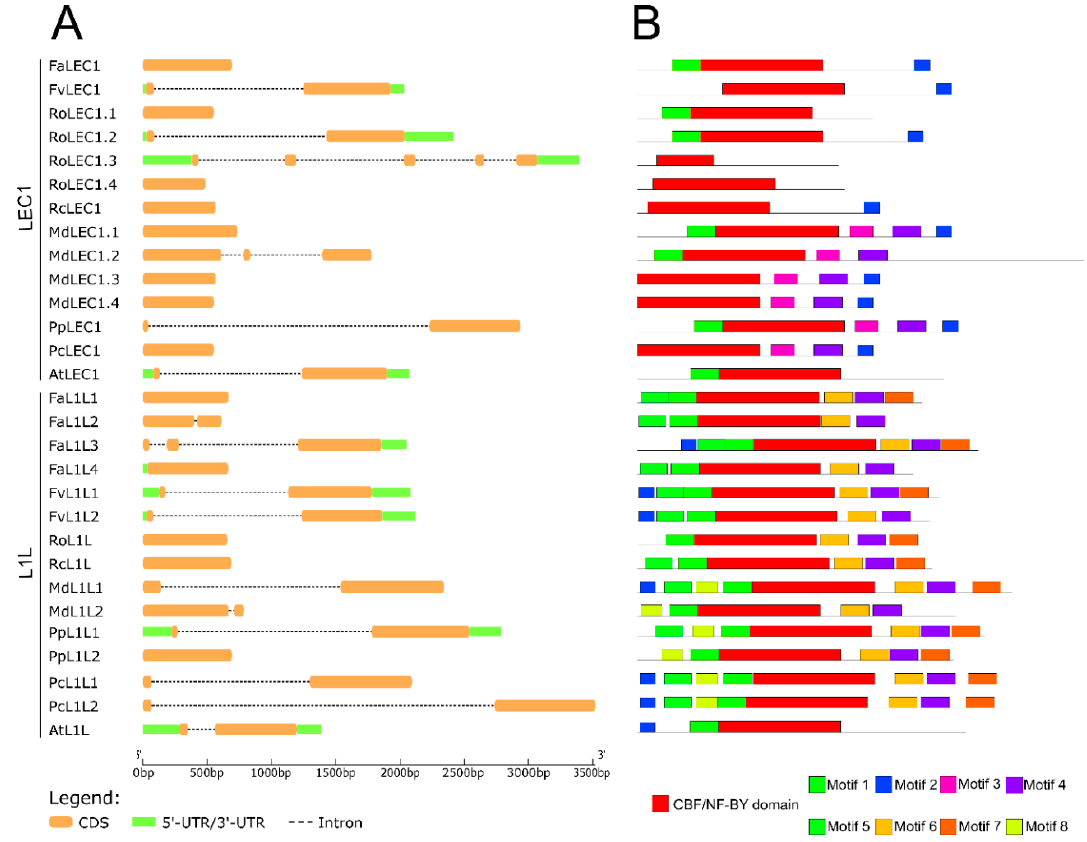
Figure 1. LEC1 and LIL1 gene and protein structures in Rosaceae species and Arabidopsis thaliana . ( A ) Exon–intron structure of LEC1 and L1L genes. ( B ) CBF-A/NF-YB domain and motifs in LEC1 and L1L proteins. LEC1 : LEAFY COTYLEDON1 ; L1L : LEAFY COTYLEDON1-LIKE; Fa: Fragaria × ananassa ; Fv: Fragaria vesca ; Ro: Rubus occidentalis ; Rc: Rosa chinensis ; Md: Malus × domestica ; Pp: Prunus persica ; Pc: Pyrus communis; At: Arabidopsis thaliana. A list of accession numbers for protein sequences is available in Table